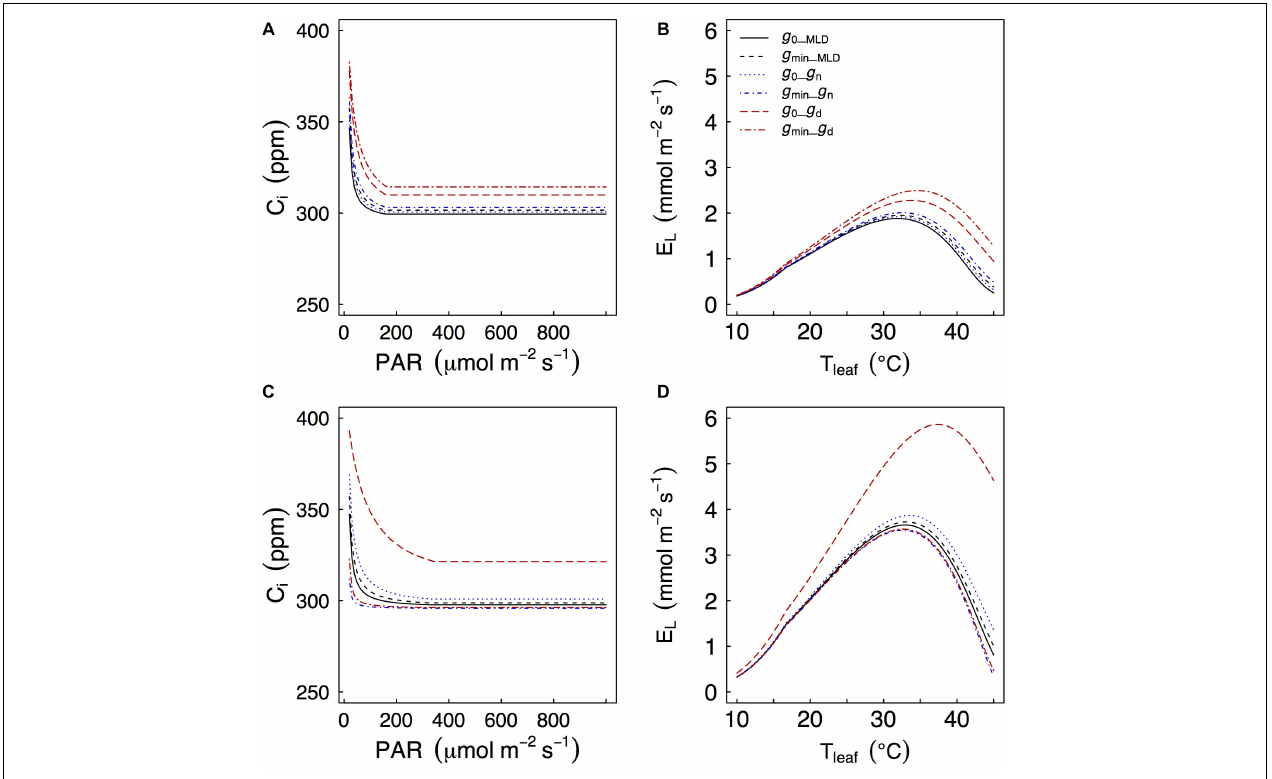
FIGURE 5 | Effects of different values of g res on a coupled photosynthesis model as in Duursma et al. (2019). Models are for Q. faginea (A,B) and Q. ilex (C,D) . g 0 and g min represent g res under low light (P 0 _shadow treatment) and water stress (P 80 _sun treatment), respectively. Subscripts MLD , n , and d indicate that g 0 or g min (depending on case) were estimated from mass loss of detached leaves, from nocturnal conductance, or from daytime